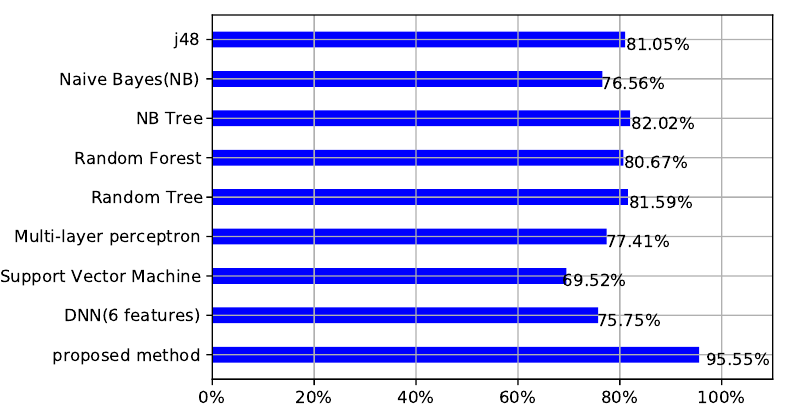
Figure 10. Accuracy performance comparison for proposed XGboost method against classical machine learning algorithms, including the DNN model in